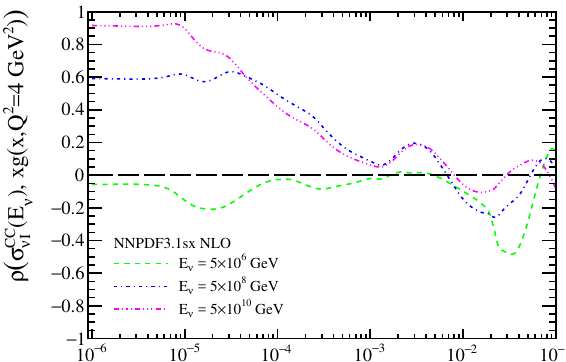
Figure 7 . The correlation coe(cid:14)cient (cid:26) between the gluon PDF at Q 2 = 4 GeV 2 and the CC neutrino-isoscalar cross-section evaluated at speci(cid:12)c values of E (cid:23) , presented as a function of the momentum fraction x carried by the